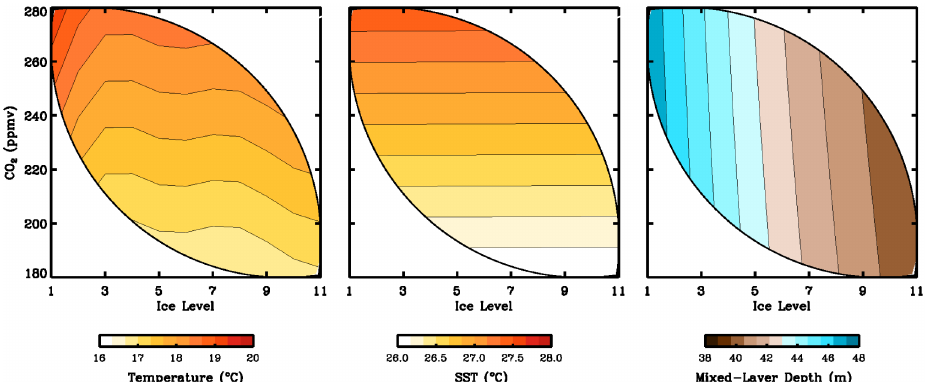
Figure 12. Sensitivity to CO 2 and glaciation level. From left to right: continental temperature, sea-surface temperature and mixed-layer depth. Fields were integrated over e sin ((cid:36)) , e cos ((cid:36)) and obliquity.